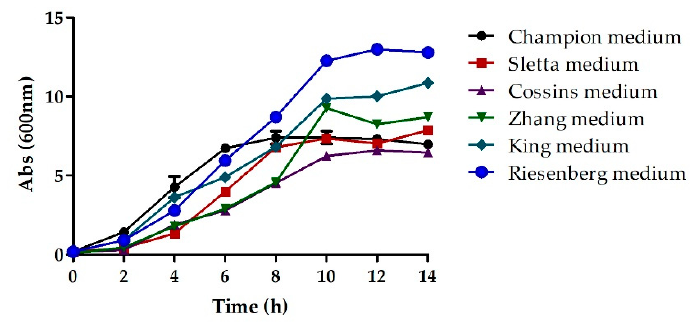
Figure 1. The cell density as a function of time plotted for different basal media.